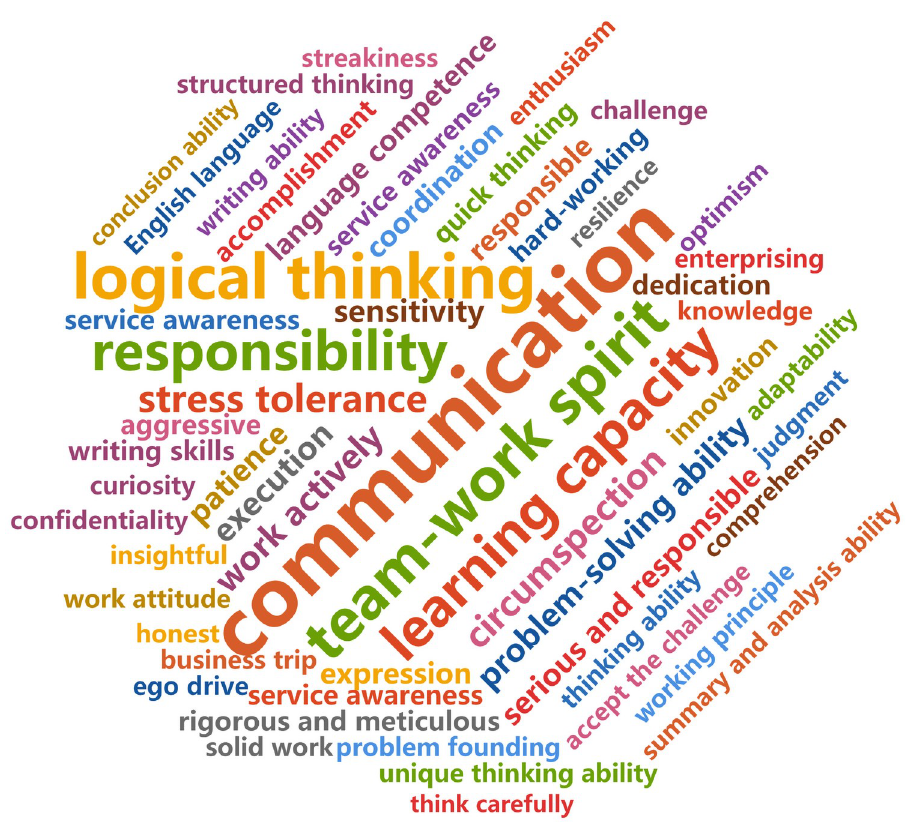
Fig 5. Cloud map of core skill